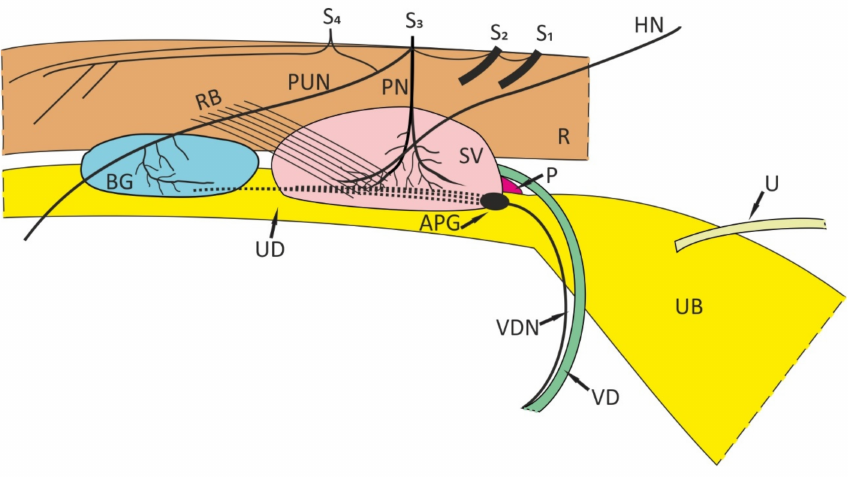
Figure 1. Schematic representation showing the distribution of ganglia in the pelvic plexus of the juvenile male pig. Lateral view. R—rectum, UB—urinary bladder, U—ureter, UD—urogenital duct, VD—vas deferens, SV—seminal vesicle, BG—bulbourethral gland, HN—hypogastric nerve, P—prostate gland, PN—pelvic nerve, PUN—pudendal nerve, RB—rectal branches, VDN—nerve bundle accompanying VD, APG—anterior pelvic ganglion, the dotted lines represent the remaining nerve cell clusters, S1–S4—spinal sacral